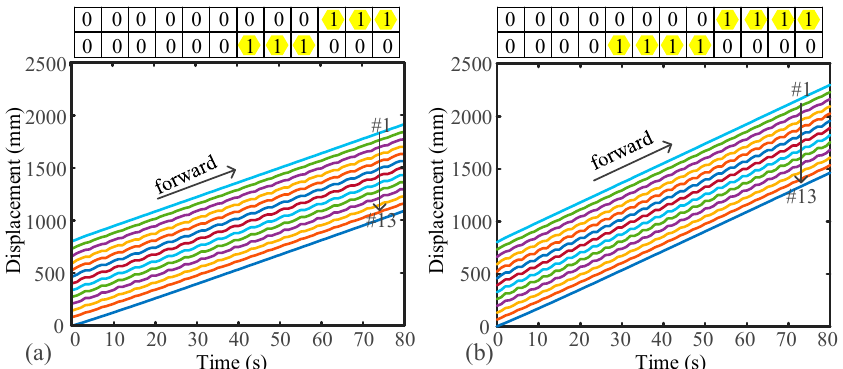
Figure 10. Locomotion simulations of a 12-segment earthworm-like robot based on U-DM under MG- Ⅰ . The line located in the number is the locomotion tracks of the body segments. ( a ) The U-DM contains three actuated segments. ( b ) The U-DM consists of four actuated segments.